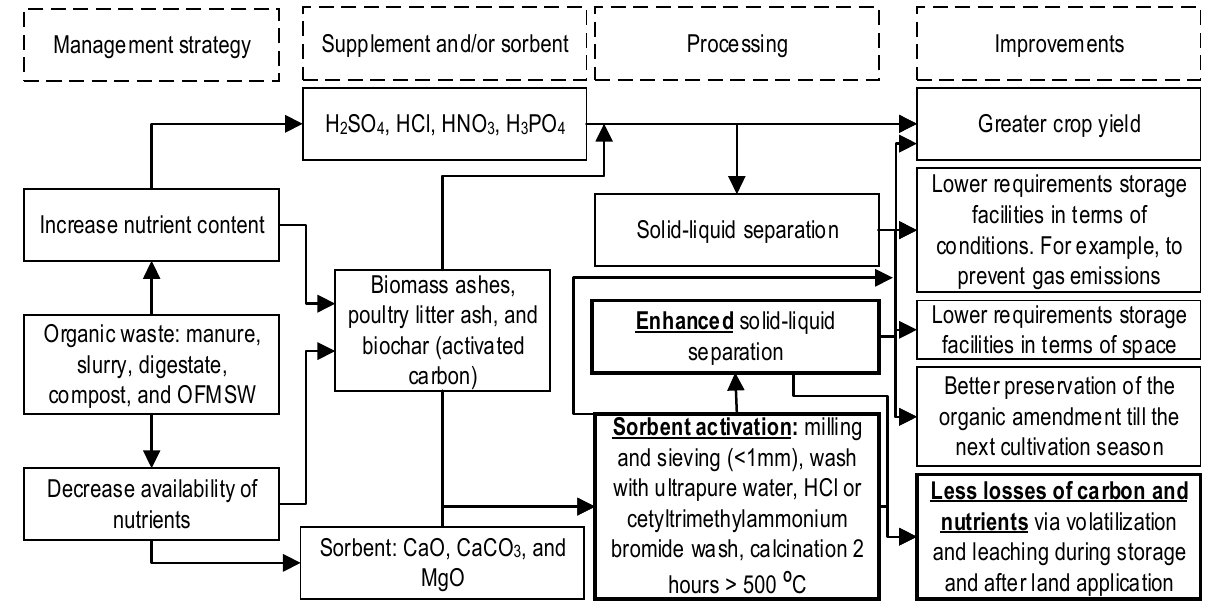
Figure 1. Management strategies for organic wastes and the intended economic and environmental improvements.